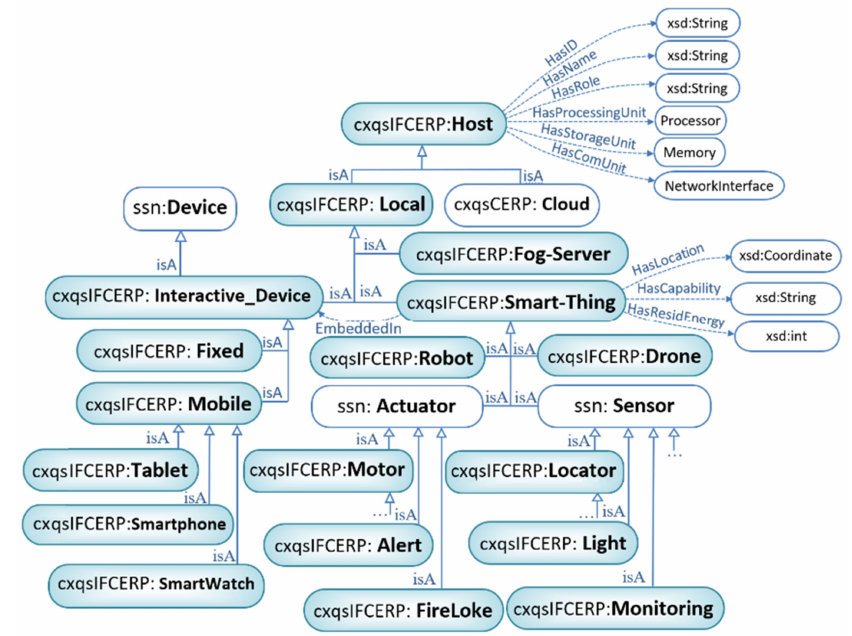
Figure 5. A semantic model of different hosts.